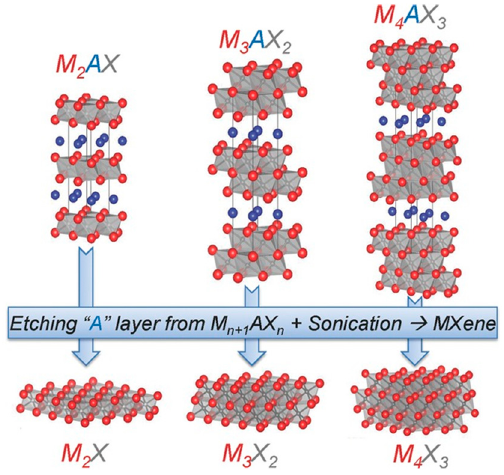
Figure 2. Structures of MAX phases and their corresponding MXene. Reprinted with permission.